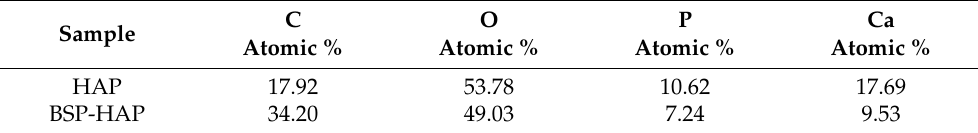
Table 1. Chemical composition of HAP and BSP-HAP from energy dispersive spectrophotometry (EDS) analysis by atomic ratio. The molar ratio of calcium to phosphorus in the BSP-HAP was 1.55. C Sample Atomic %